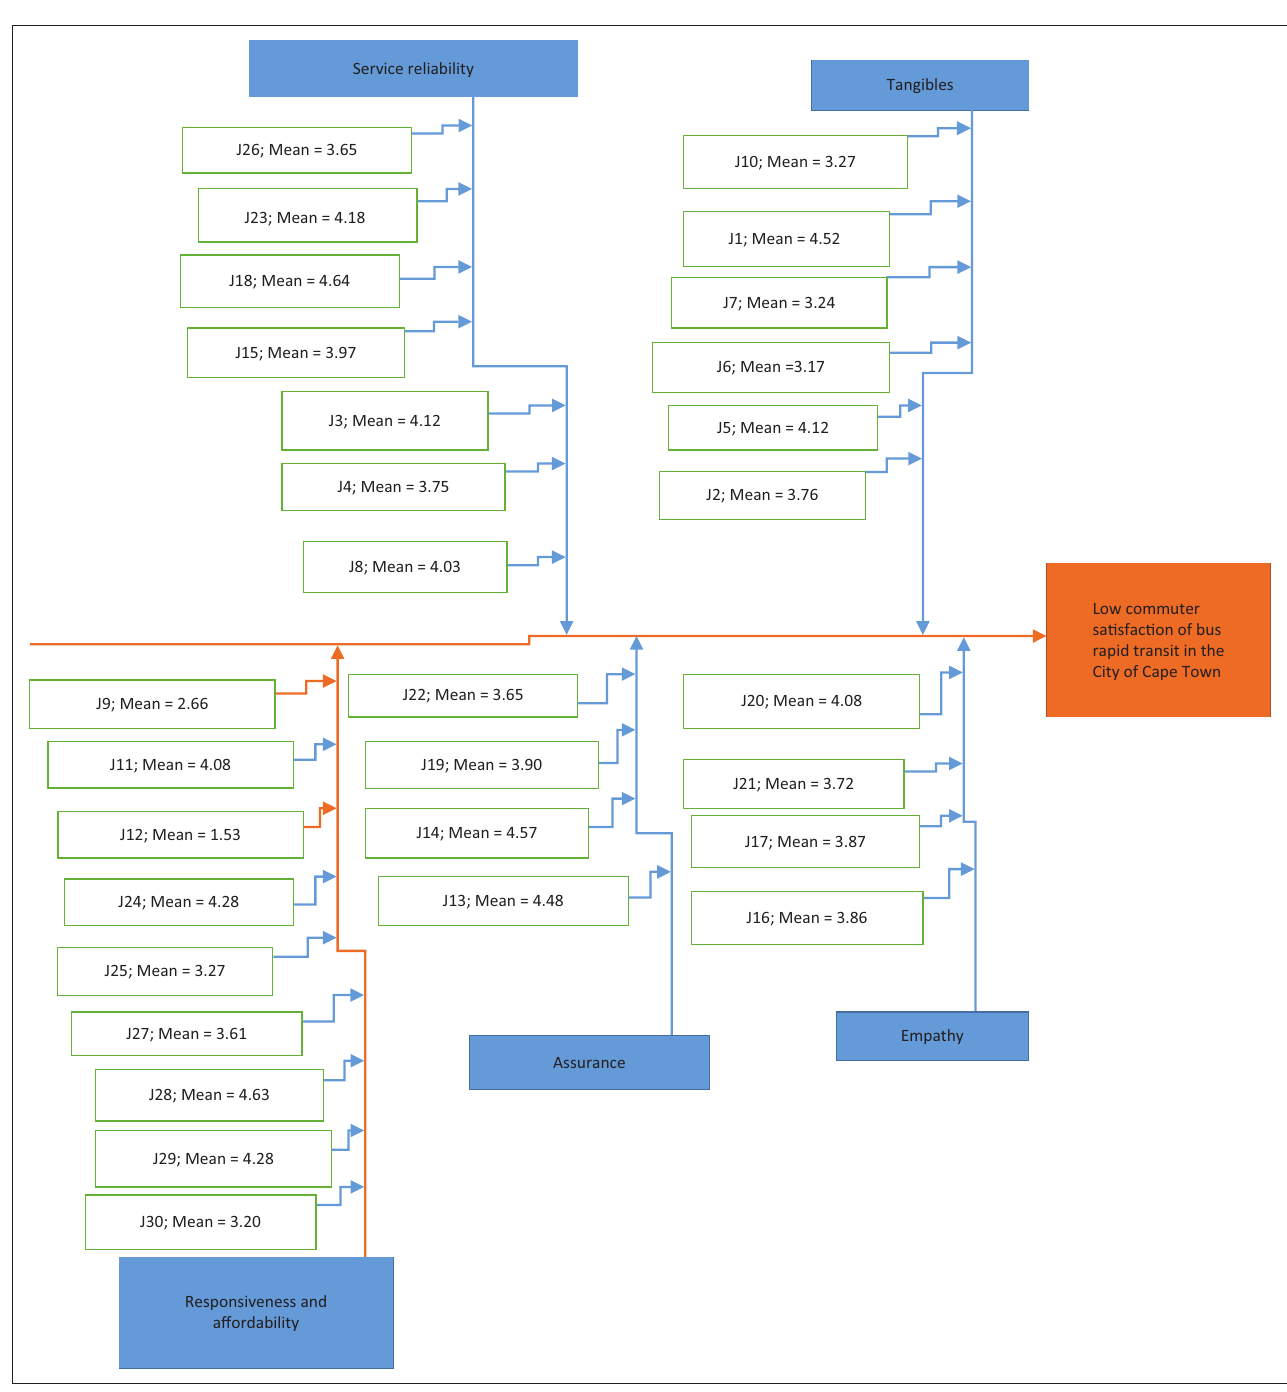
FIGURE 3: Result overview – service quality variables and mean